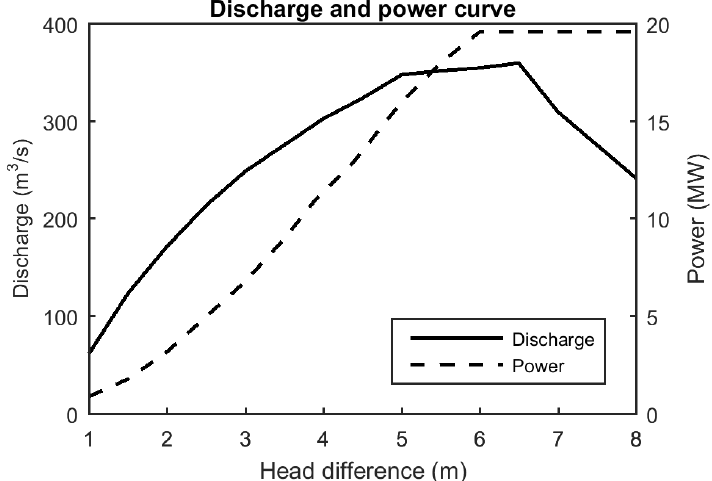
Figure 9. Q-H and Power-H relationship characteristic for bi-directional turbines used in the